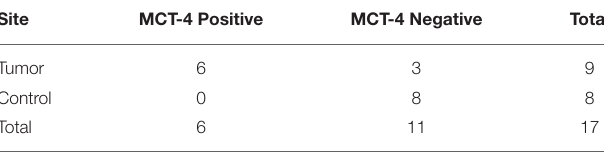
TABLE 2 | HNSCC MCT4 Expression in CD163-positive